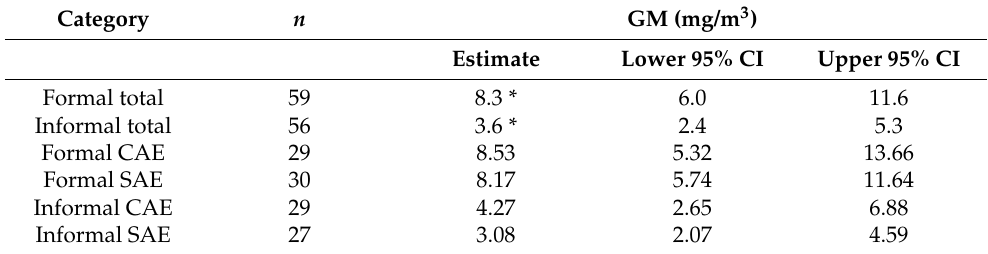
Table 3. Restricted maximum likelihood estimates of the geometric mean (GM) exposure to adj TVOC in the formal and informal sector, separately and averaged, over the level of assessment regime (N formal = 59, N informal = 56). CI, confidence interval. The asterisk indicates a statistical significance